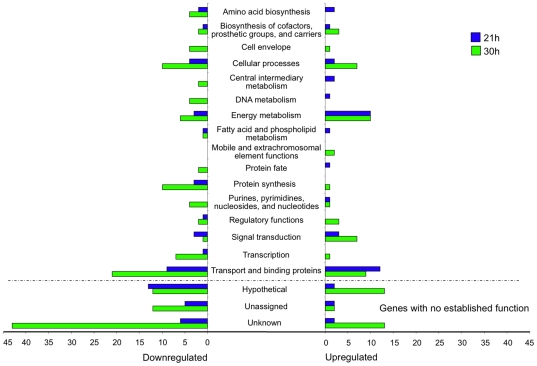
Differential regulation of S. mutans gene expression in suc+st-biofilms at 21 and 30 h.Genes were classified into 19 main functional classes (some genes have more than one functional class). Bars indicate the numbers of genes whose expression was modified at 21 h (blue bars) and 30 h (green bars). On the left, genes that were downregulated in suc+st-biofilms (vs. suc-biofilms): 52 and 147 genes for 21 h and 30 h, respectively. On the right, genes that were upregulated in suc+st-biofilms (vs. suc-biofilms): 42 and 73 genes for 21 h and 30 h, respectively. Suc+st-biofilms were formed in 0.5% sucrose +1% starch; suc-biofilms were formed in 1% sucrose. Gene annotations are based on information provided by the Los Alamos National Laboratory (www.oralgen.lanl.gov) or by published literature available at the same Website.